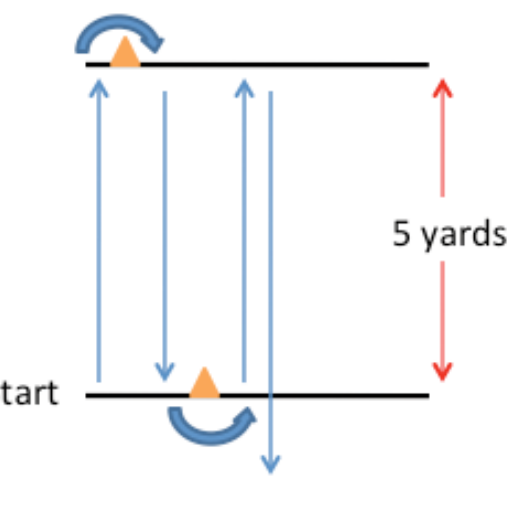
Figure 5-34. Nebraska Agility Drill